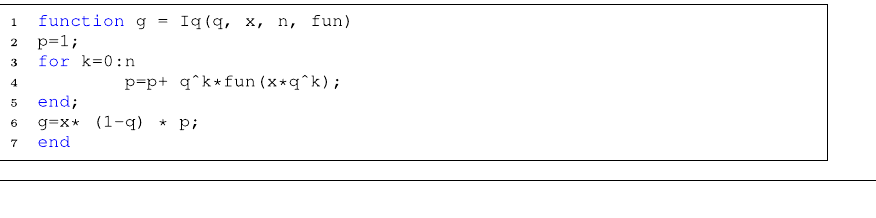
Algorithm 5 The proposed method for calculated I α